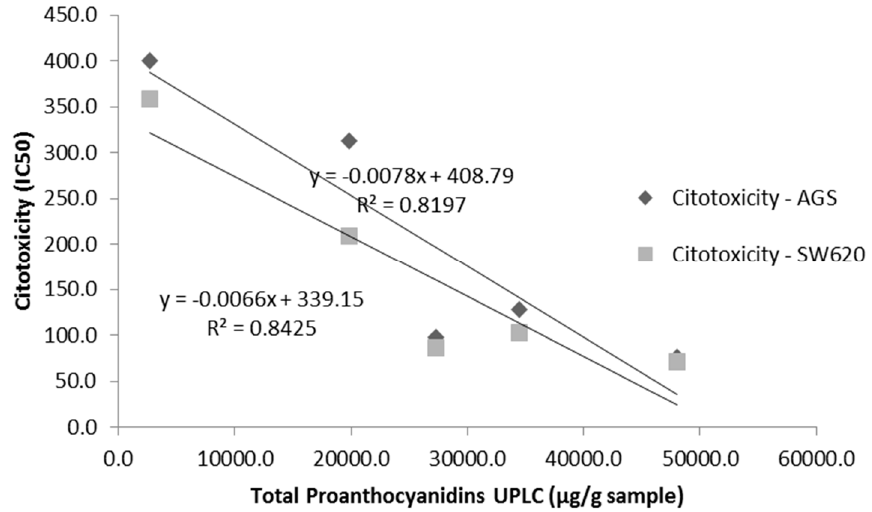
Figure 3. Correlation between total proanthocyanidin contents (UPLC/TQ-ESI-MS) and cytotoxicity on AGS and SW620 adenocarcinoma cell lines.